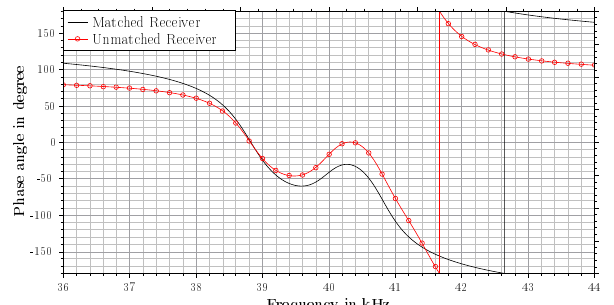
The difference between the measured magnitudes in Fig. 8 for the measurement resistors R m = 1400 (cid:127) and R m = 1300 (cid:127) is marginal. Hence the use of standard resistors